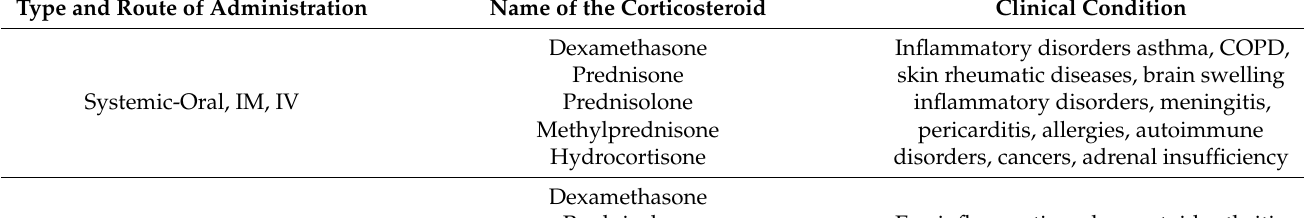
Table 2. Summary of commonly used corticosteroids and the frequent clinical conditions necessitating their use. Type and Route of